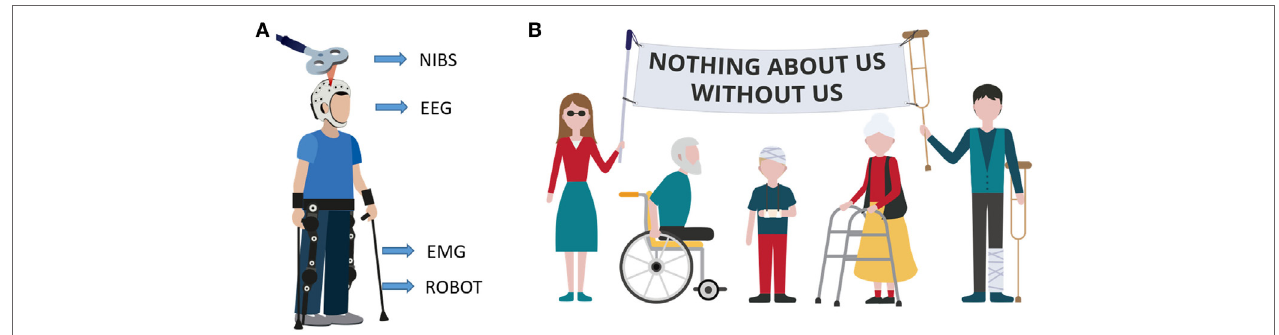
FigUre 2 | Innovative patient-tailored approach. (A) Example of multimodal rehabilitative approach. Subject is using an exoskeleton while receiving brain stimulation. Both exoskeleton motors and stimulation parameters are updated based on subject’s biofeedback signals (electroencephalography and/or EMG) and on subject performance (ROBOT) while, at the same time brain stimulation non-invasive brain stimulation and exoskeleton assistance (ROBOT) influence the biosignals. (B) Motto of the disabled population. The motto means that any choice (in any field) regarding them must be taken with their direct participation. Rehabilitation research must follow the same